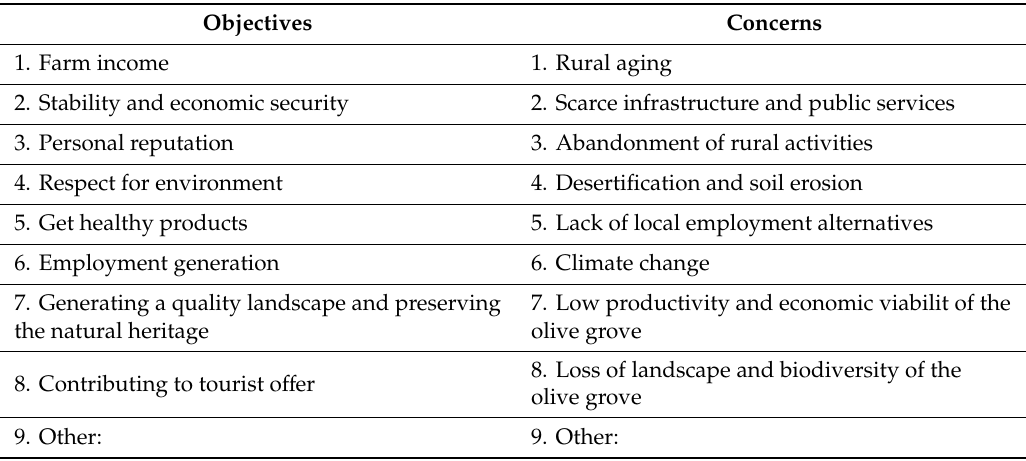
Figure 2. Sample design in the Estepa region, highlighting the sampling points where the surveys were carried out according to the agricultural management (i.e., integrated or organic) and the erosive state of the plots (i.e., null, slight, moderate, or severe). Table 3. List of agricultural objectives and concerns proposed to farmers for assessment. In the “Other” section, farmers were able to suggest options not incorporated in the designed